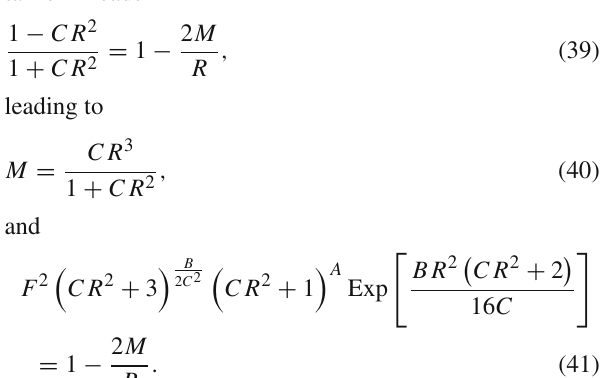
anddifferentvaluesoftheparameters A , B , C and F mentionedinTable 1. It should be noted that, as we are working in relativistic geometrized units, the vertical axis has units of [ km − 2 ] for the left panel, while for the right one is